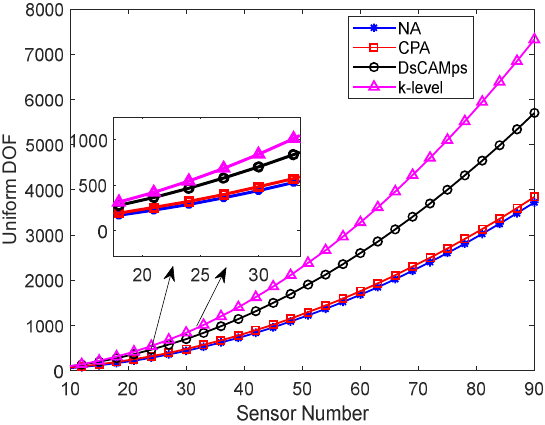
Figure 6. The comparisons of uniform DOF.